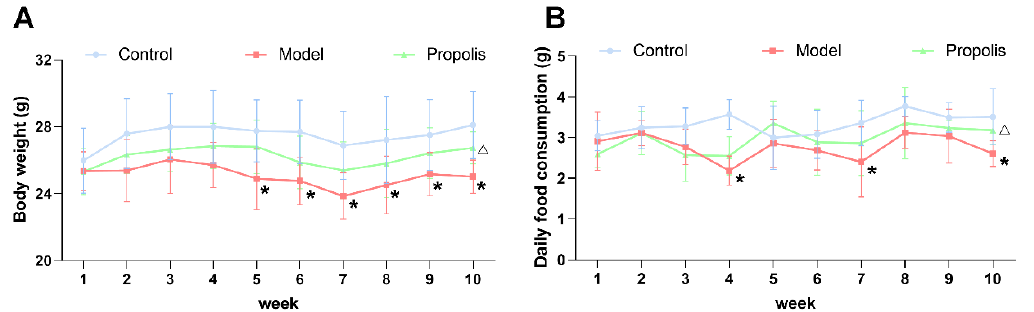
Figure 1. Body weight and daily food consumption in mice within 10 weeks. The average body weight ( A ) and average daily food consumption ( B ) of the mice in the three different groups. * Denotes p < 0.05 vs. control group; △ p < 0.05 vs. model group.